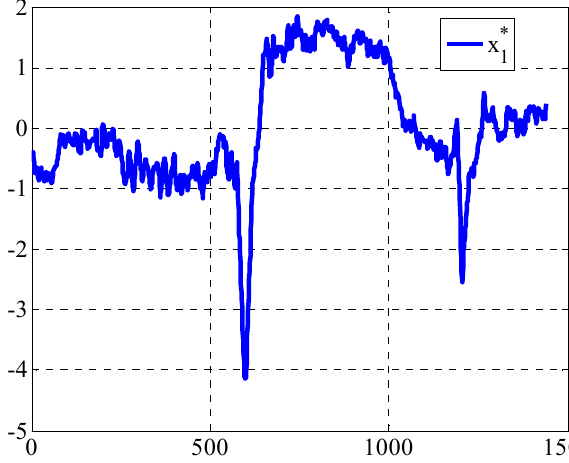
Figure 21. The standardized variable x ∗